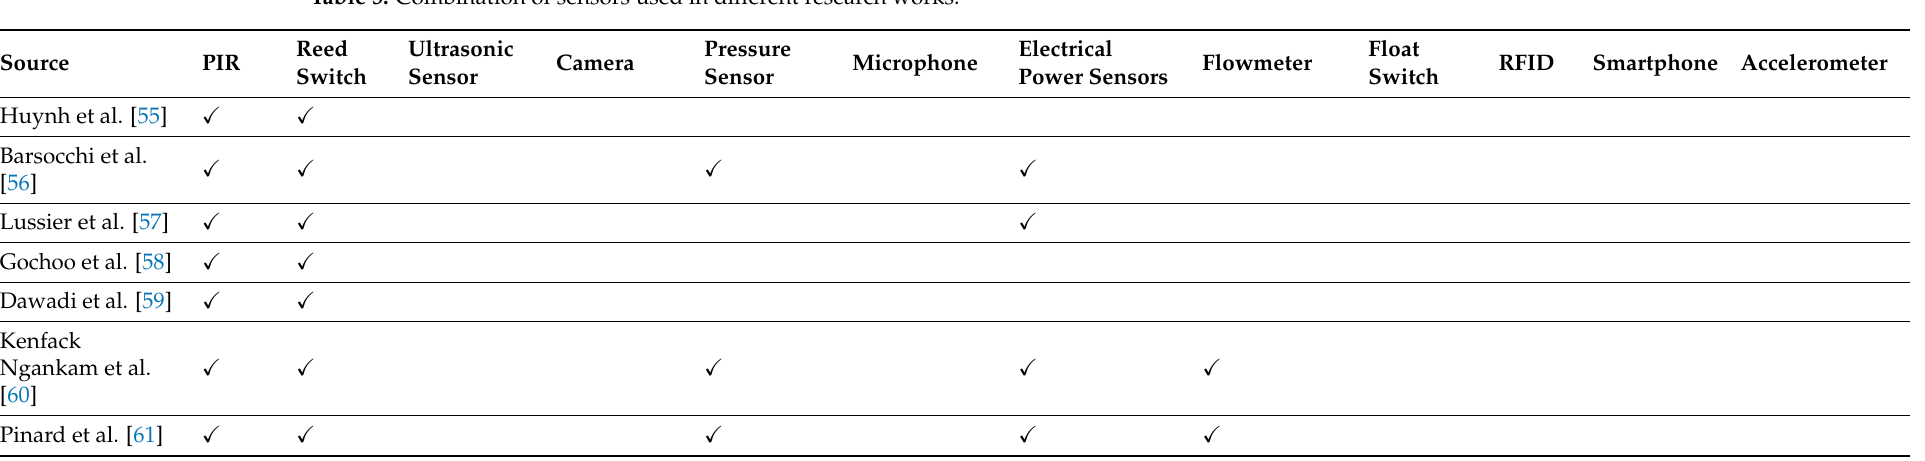
Table 5. Combination of sensors used in different research